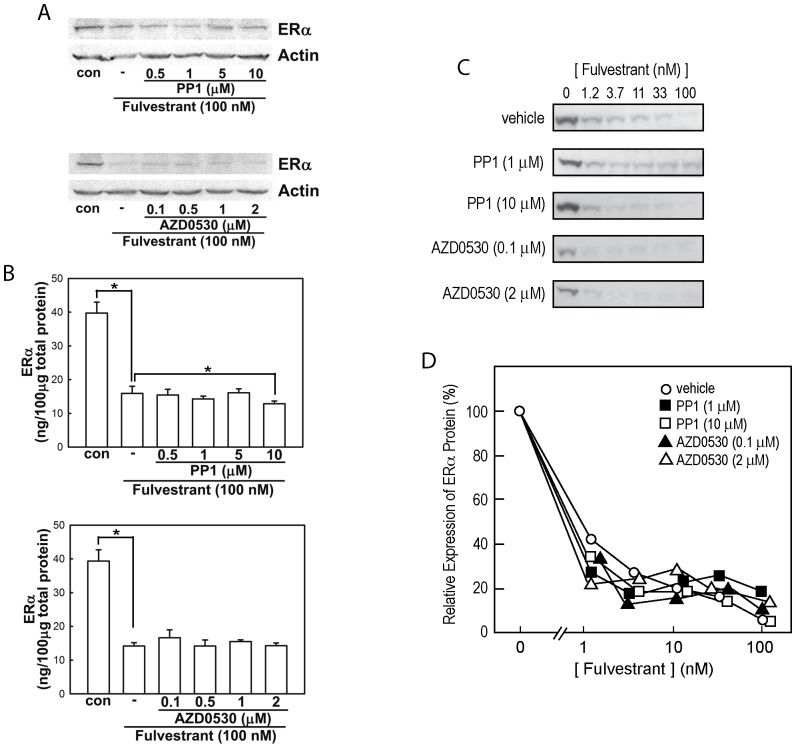
PP1 or AZD0530 tyrosine kinase inhibitors had no effect on ERα protein degradation in MCF-7 cells.In panels (A) and (B), ERα protein expression after 6-hour exposure to 100 nM fulvestrant in the presence of PP1 or AZD0530 was determined by Western blotting (A) and ELISA (B, mean±SEM of three or more independent experiments. Asterisks indicate statistical significance, p<0.05, to fulvestrant-only group). In panels (C) and (D), fulvestrant concentration was reduced as indicated, and ERα protein expression after 6-hour exposure in the presence of PP1 or AZD0530 was determined by Western blotting (C). Panel (D) shows a typical densitometric quantitation of the ERα protein band. Three independently performed experiments did not show statistically significant effects of PP1 or AZD0530.